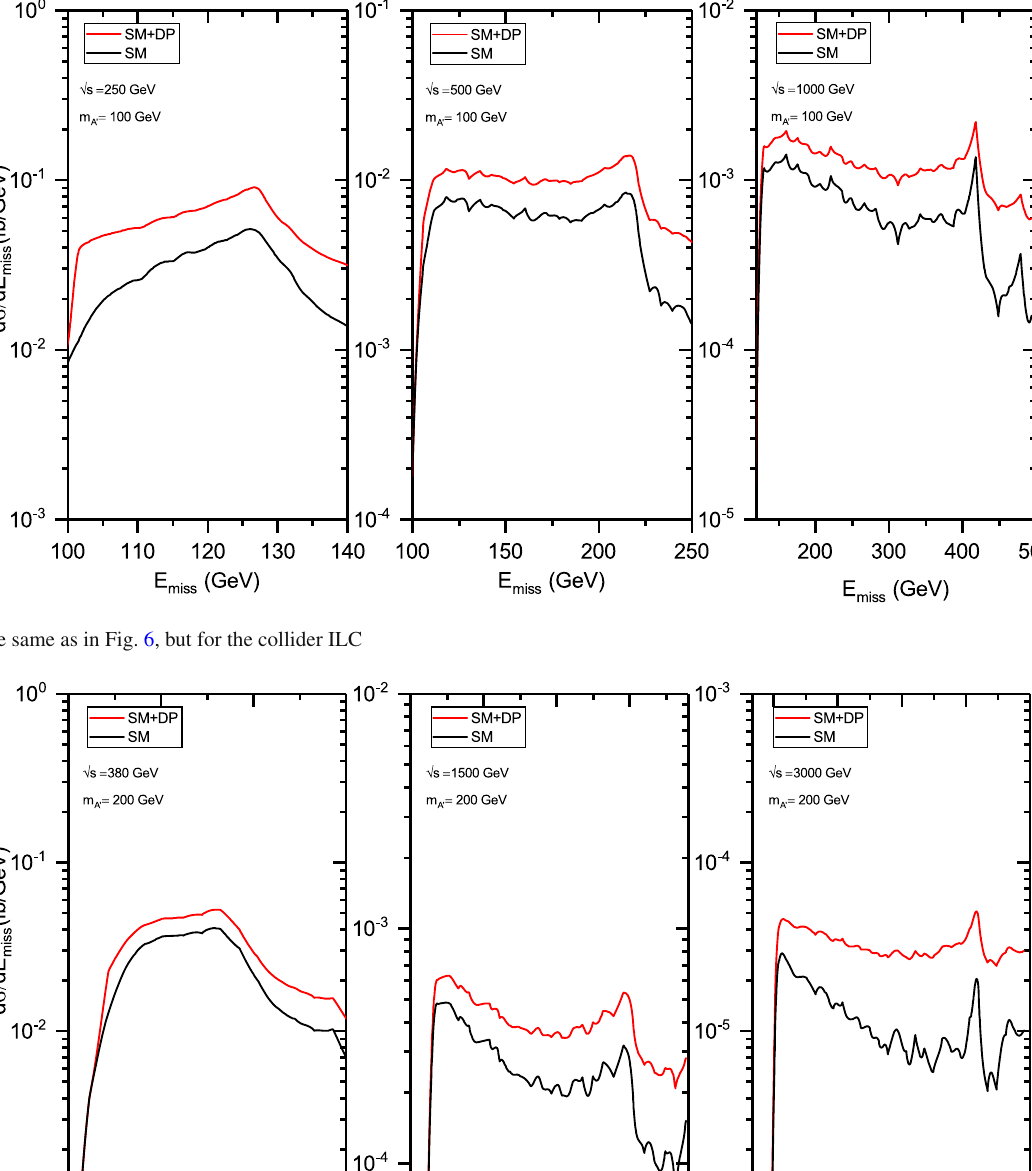
Fig. 8 The same as in Fig. 6, but for the collider CLIC